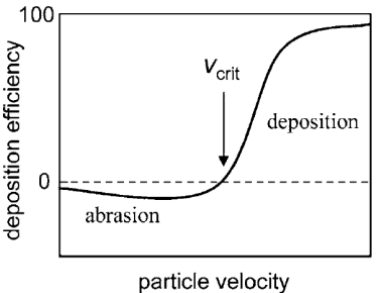
Figure 5: The effect of particle velocity on deposition efficiency in CGDS